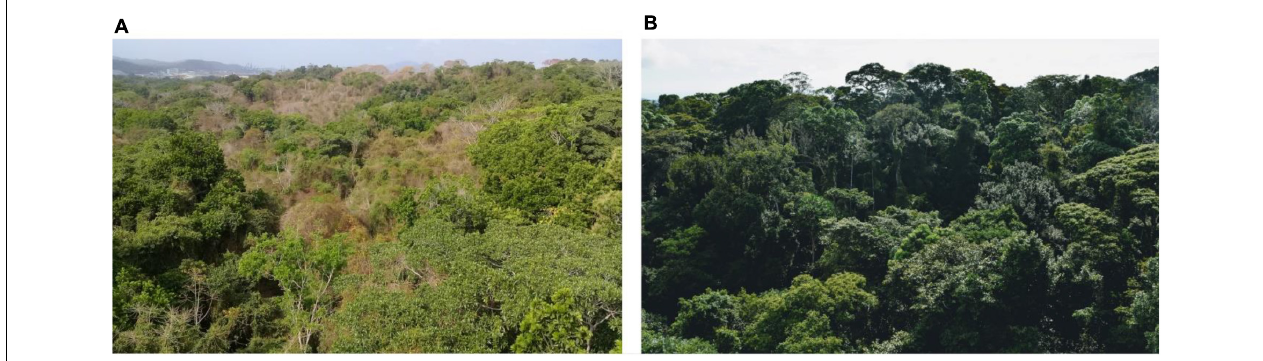
FIGURE 1 | Photo of the two study sites taken during the dry season. (A) Parque Natural Metropolitano a seasonally dry tropical forest and (B) Parque Nacional San Lorenzo a wet evergreen tropical forest. Photo (A) was taken by Brett T. Wolfe.